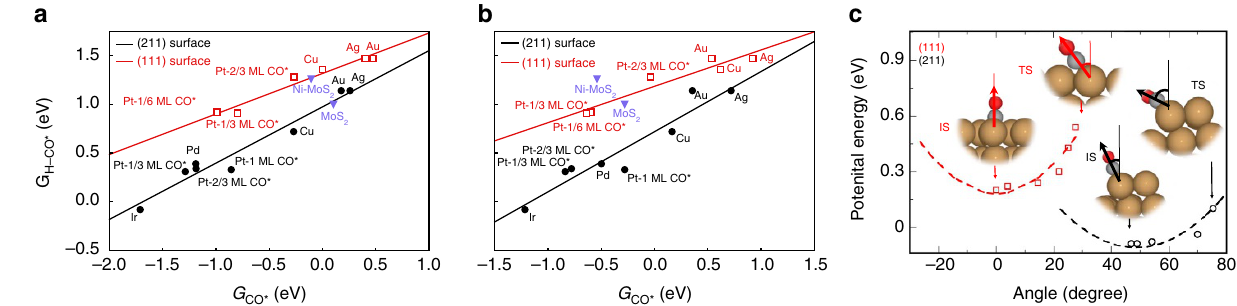
Figure 2 | Scaling relations of CO reduction transition state energies on (111) and (211) transition metal facets. ( a ) G H–CO* versus G CO* ( b ) G H–CO* versus G CHO* . ( c ) Potential Energy curves for CO adsorbed Cu(111) and Cu(211) as a function of the angle of rotation. For Cu(111) a rotation of adsorbed CO is more energetically costly from initial state to transition state with respect to the stepped Cu(211) surface, which rationalizes the lower transition state energies for stepped surface. All energies are referenced to solvated protons far from the surface at pH ¼ 7, electrons at 0V versus RHE and gas phase CO at T ¼ 300K, P ¼ 1bar.